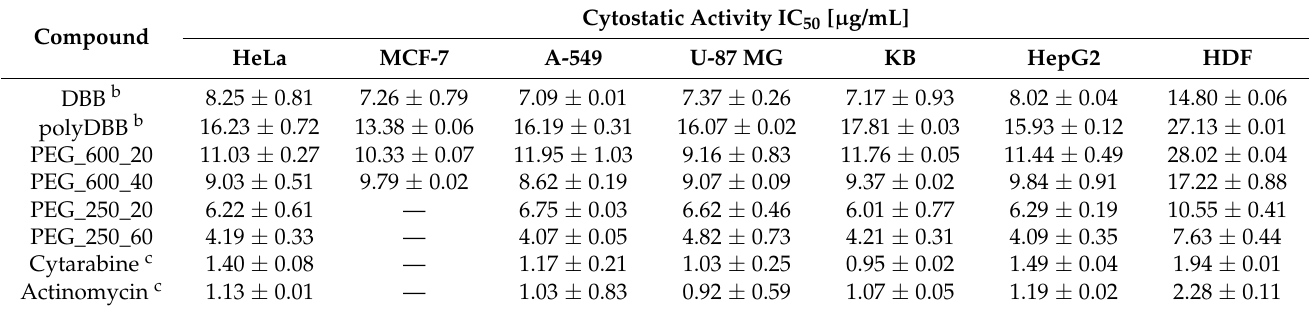
Table 3. Cytostatic activity of DBB and polyanhydrides against various cancer cell lines as well as a normal control (HDF), expressed as IC 50 a